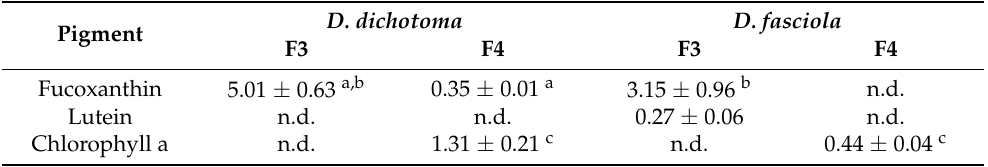
Table 4. The pigment composition of D. dichotoma and D. fasciola determined by HPLC. The results are presented as the average area of three replicates expressed in mg/g of a dry fraction with standard deviation. Values with the same letter within a row are significantly different ( p < 0.05).